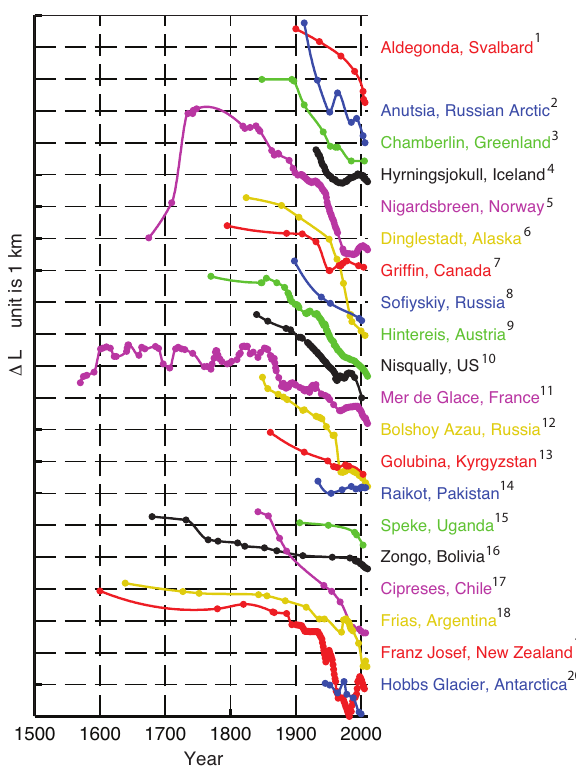
Fig. 1. Examples of glacier length records from different parts of the world. Each dot represents a data point. Data points are connected with Stineman interpolation. Data from WGMS (2012; and earlier volumes, and references therein), with additions from 1